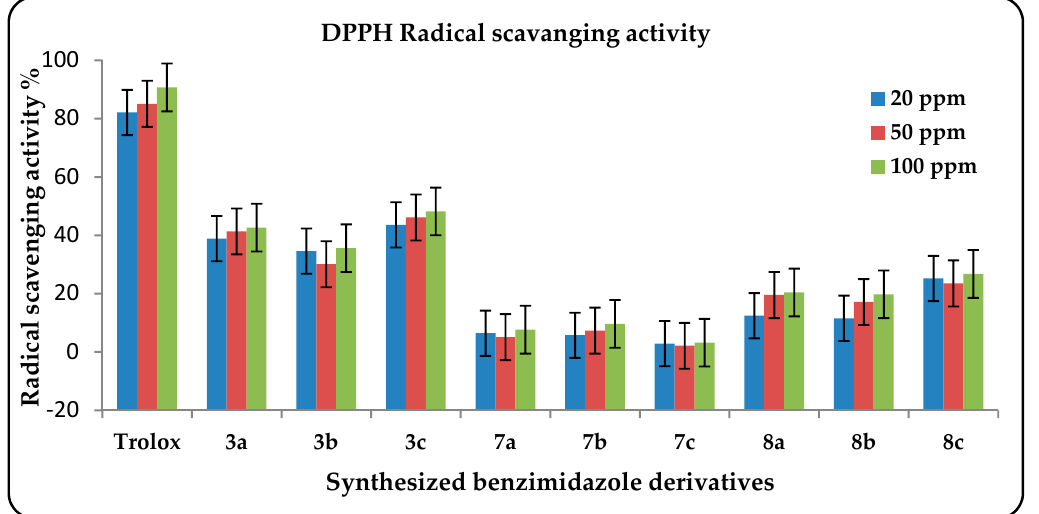
Figure 2. Inhibition percentage average results of DPPH radical by the tested synthesized benzimidazoles based on three independent experiments.